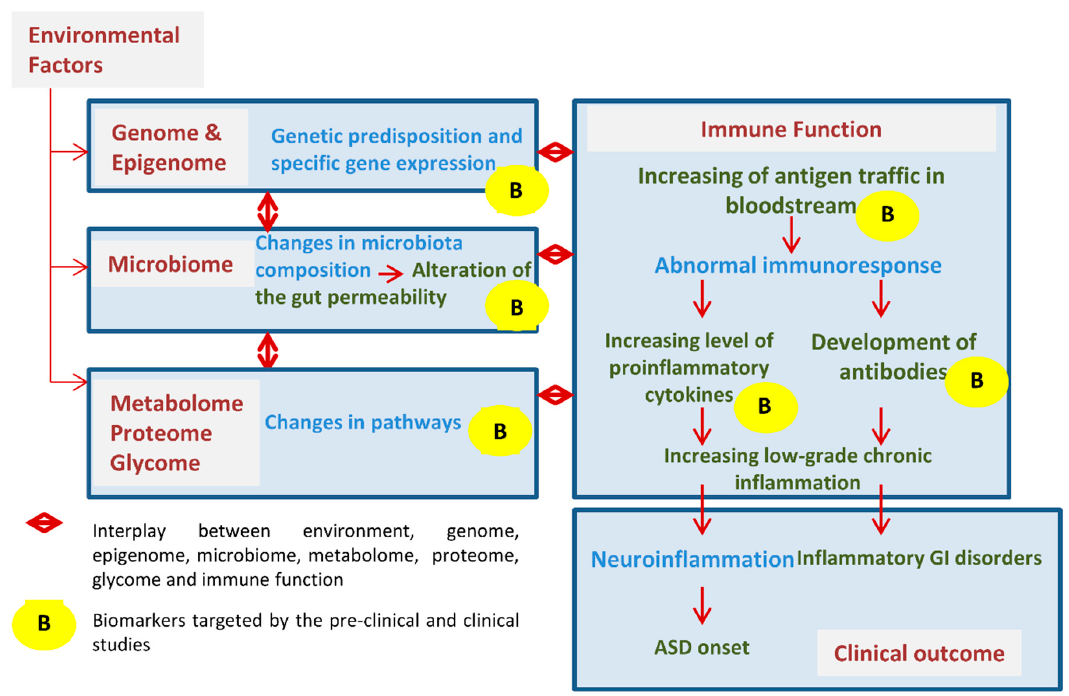
Figure 1. GEMMA (Genome, Environment, Microbiome and Metabolome in Autism) study design.